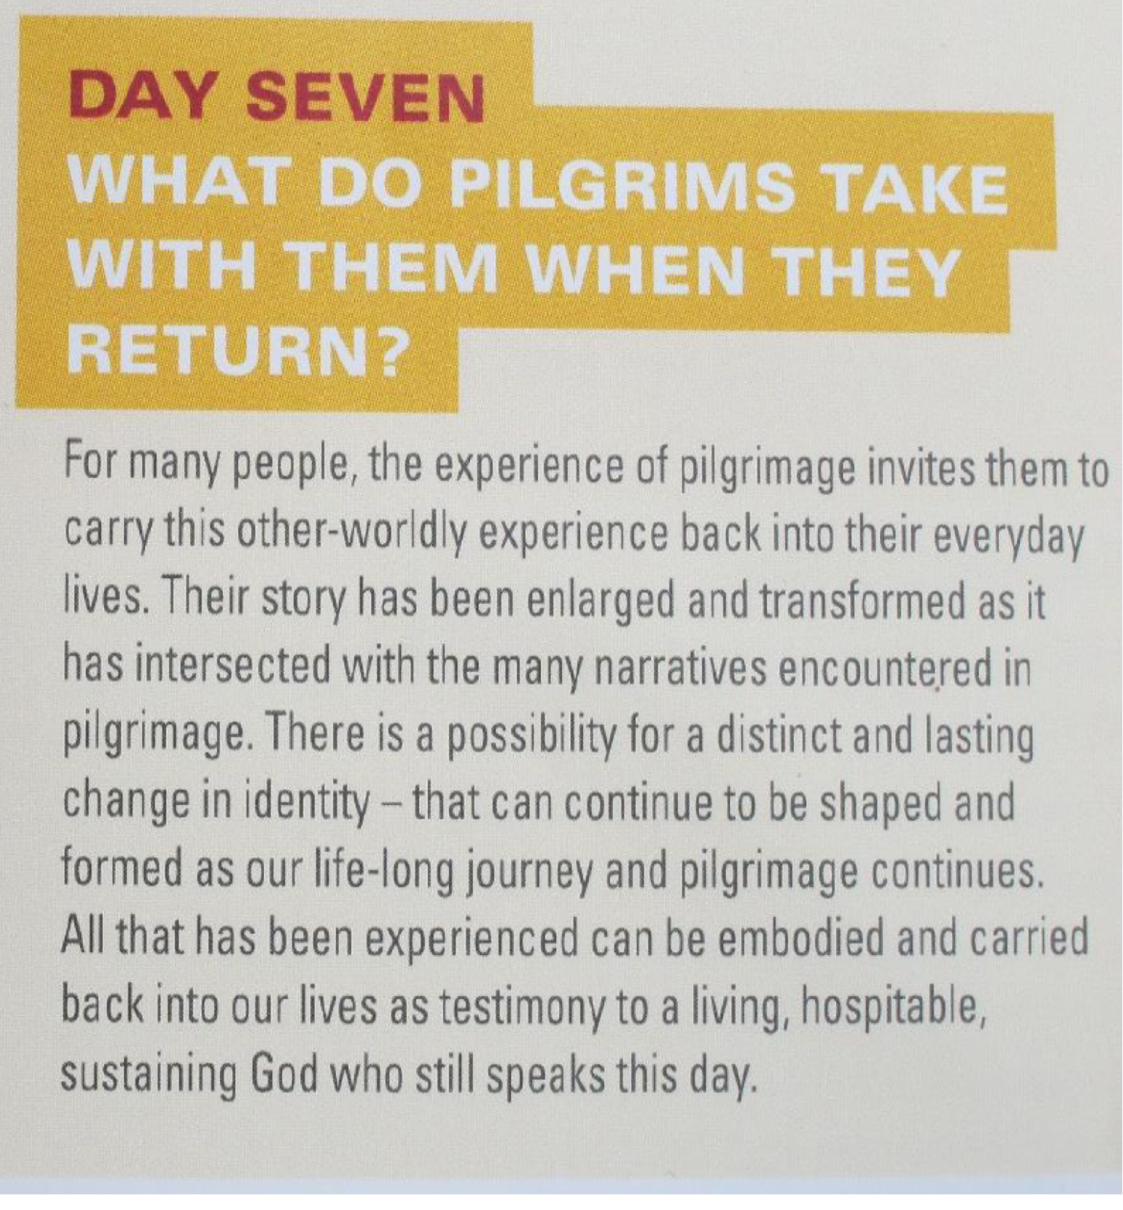
Figure 4. What do pilgrims take home with them? Praying the Keeills 2011 programme extract (courtesy of Praying the Keeills).